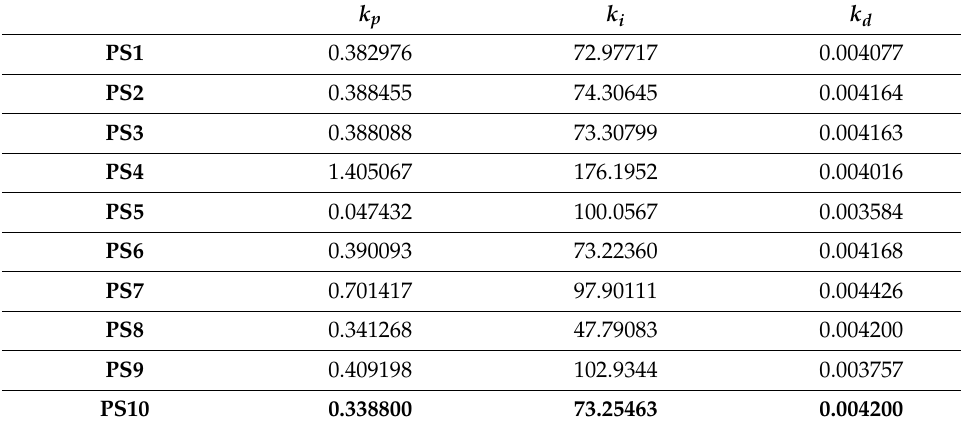
Table 2. Tuning of PID controller in turn off.